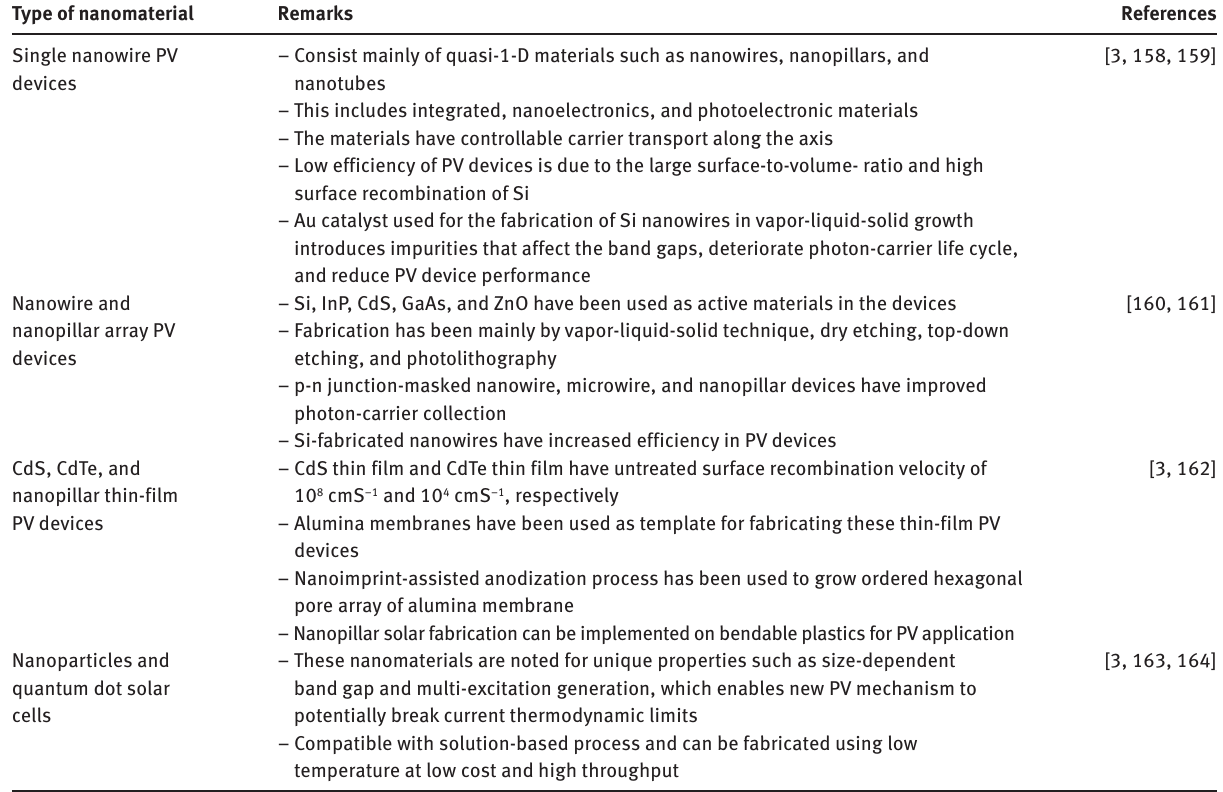
Table 3: Summary of nanomaterials and nanostructure photovoltaic (PV) devices. Type of